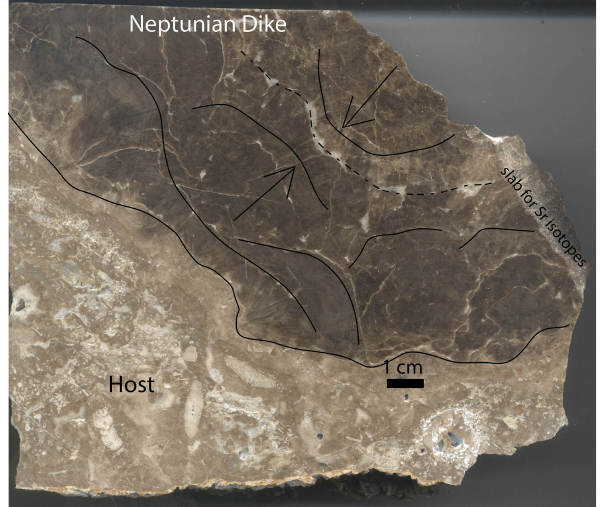
Figure 2. Large hand sample from a Neptunian dike at Walnut Canyon. The lighter brown limestone on the left is the reef rock, with abundant large forams clearly visible. The dark brown botry- oids can be seen growing from both sides of this oblique slab through the dike carbonate. Curved lines show approximate botry- oid boundaries and arrows point in the growth direction. The dashed line is approximately the center of the dike. A white calcite cement lines many of the botryoids and occurs in the center of the dike. A slab from the host to the center was analyzed for the Sr isotopes presented in this